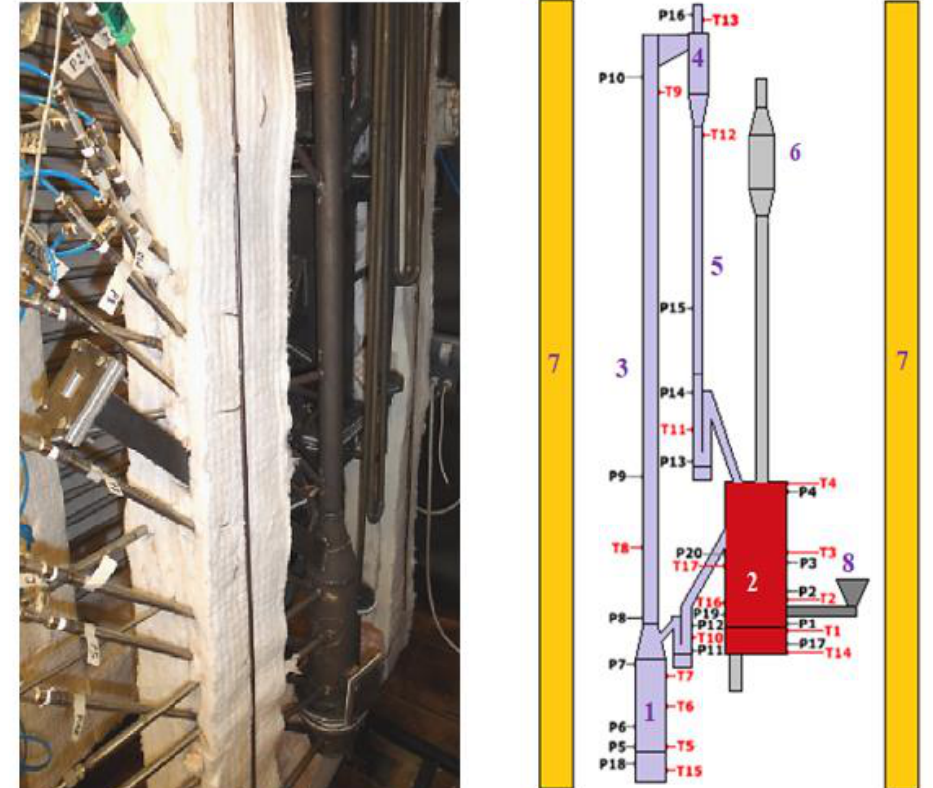
Figure 4. The hot FB-CLC-SF facility; 1—air reactor, 2—fuel reactor, 3—riser, 4—cyclone, 5—downcomer, 6—particle’s collector, 7—heaters, 8—screw feeder, P1—P19—pressure transducers, and T1–T16— thermocouples [15]. Table 1. Properties of fuels (as